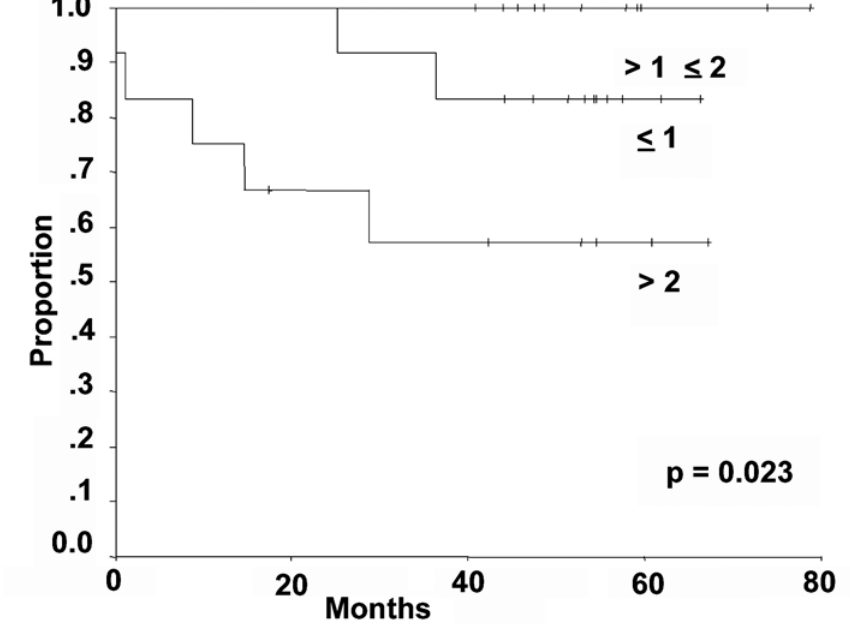
Figure 4 – Actuarial survival rate free from biochemical recurrence after survival conformal radiotherapy for groups of patients with pre-radiotherapy PSA ≤ 1, > 1 ≤ 2, > 2